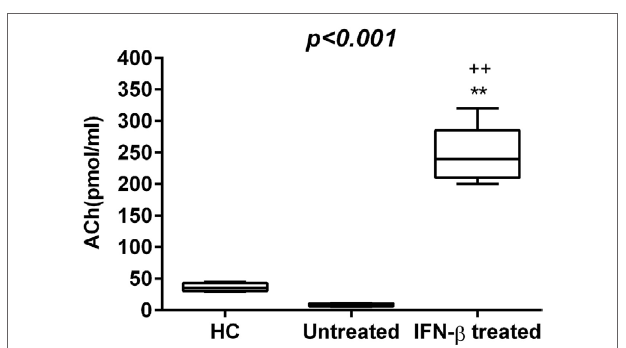
FigUre 4 | Acetylcholine (Ach) levels (pmol/mL) in the three study groups. Box–whisker plots show the 25th and 75th percentile range (box) with Tukey 95% confidence intervals (whiskers) and median values (transverse lines in the box). ++ p < 0.01 IFN- β -treated vs untreated; ** p < 0.01 IFN- β -treated vs healthy controls (HC) post hoc analysis. p -Value reported in figures are relative to the Kruskal–Wallis H